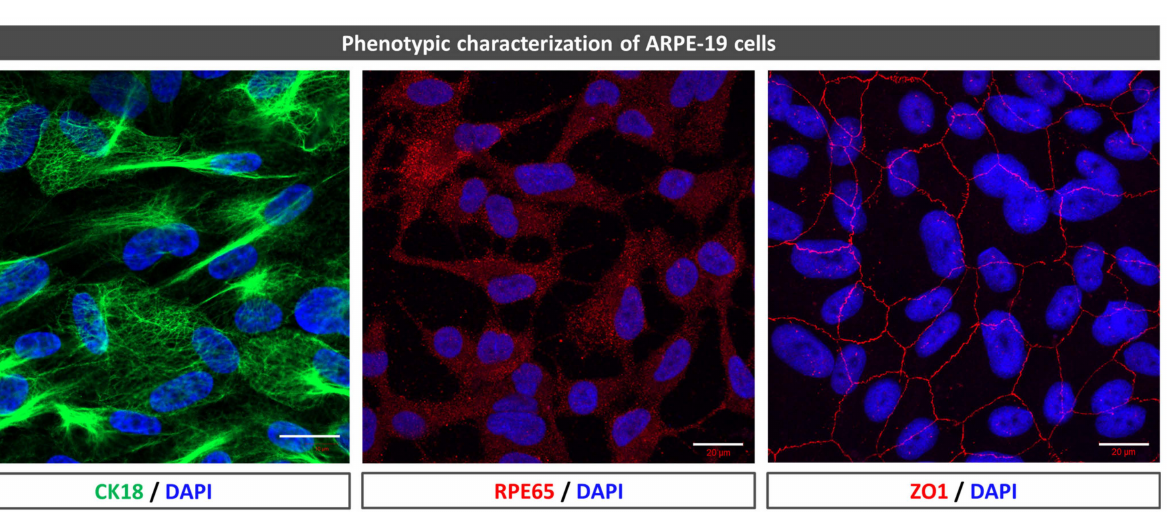
Figure 1. Phenotype confirmation of ARPE-19 cell culture. Immunofluorescence of ARPE-19 cells cultured for 2.5 months labeled with CK18 ( left image, green), RPE65 ( middle image, red), and ZO1 ( right image, red). Nuclei were labeled with DAPI (blue). CK18 = cytokeratin 18; RPE65 = retinal pigment epithelium-specific protein 65 kDa; ZO1 = zonula occludens-1. Scale bar: 20 µ